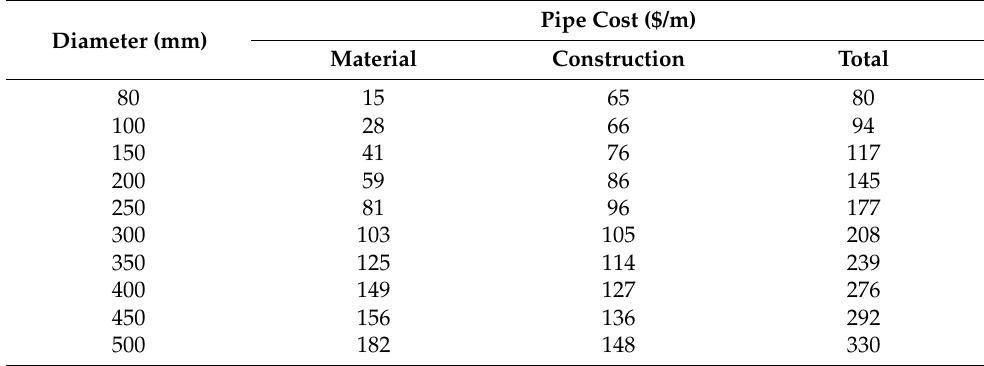
Table 1. Initial cost data of ductile iron pipe [35].